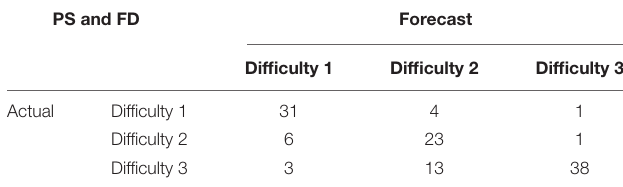
TABLE 7 | The discrimination classification results for the test